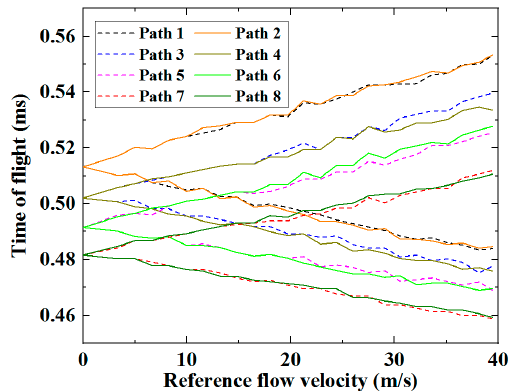
Figure 5. ( a ) Variations of pressure and temperature in the calibrated reference mechanical meter and the ultrasonic flow meter for different flow rates, where the ultrasonic meter pressure is a constant 1 atm; and ( b ) the comparison between flow velocity measured by the reference mechanical meter and the deduced reference flow velocity for the ultrasonic flow meter.